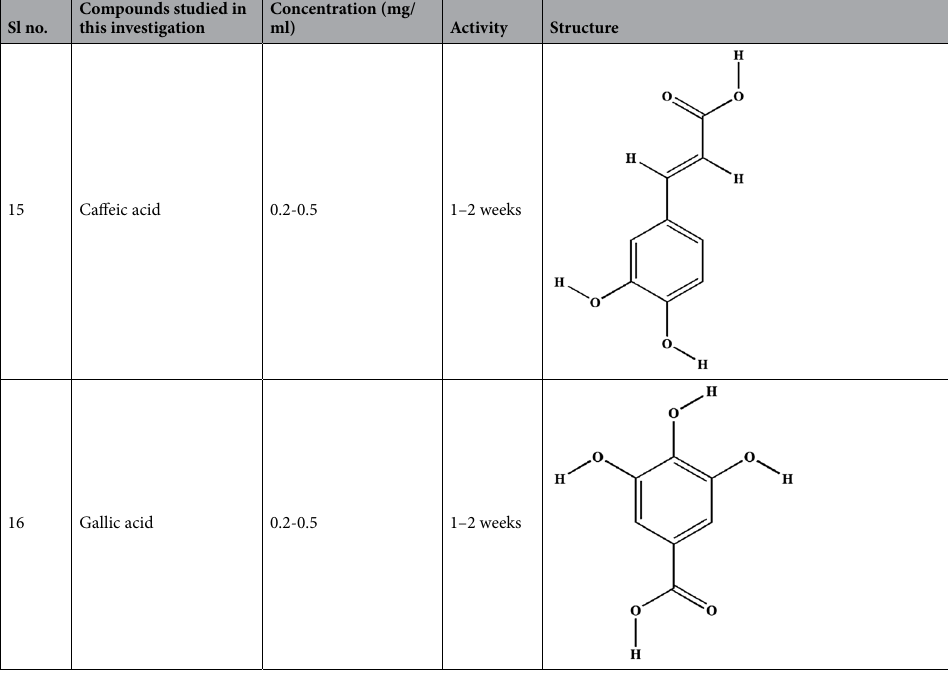
Table 2. Sprouting inhibition efficiency of various organic acids (namely l-tartaric acid, maleic acid, d-tartaric acid, oleic acid, palmitic acid, stearic acid, fumaric acid, malic acid) and aromatic acids (namely salicylic acid,